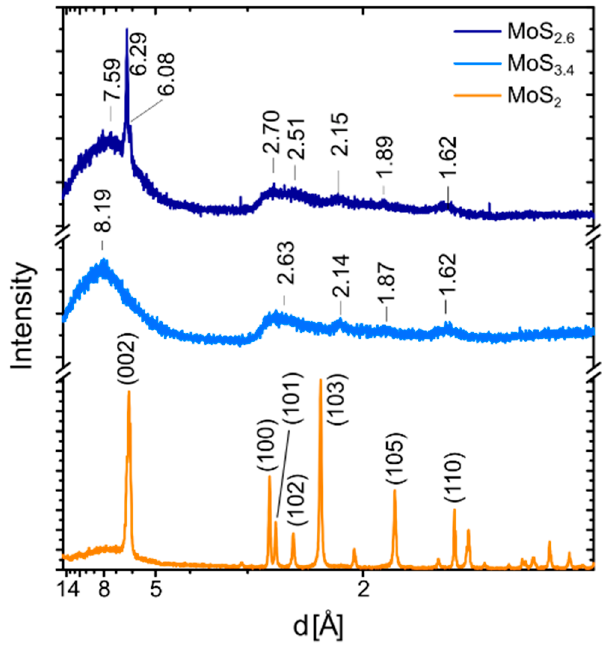
Figure 2. Powder X-ray diffraction (XRD) pattern of MoS 2 and the nanocrystalline, partially disordered samples MoS 2.6 and MoS 3.4 . The indicated diffraction maxima are determined by fitting of a gaussian function.